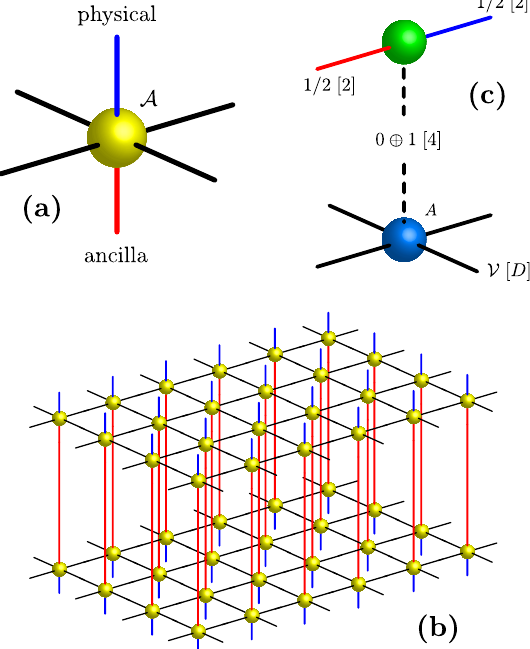
Figure 1: (a) Elementary SU(2)-symmetric C -symmetric on-site tensor A . (b) Ther- 4 v mal density operator written as an (infinite) double layer. A thermal expectation value is obtained by applying local operators on the physical (blue) legs and tracing over all degrees of freedom. (c) Construction of the rank-6 local tensor by contract- ing rank-5 and rank-3 SU(2)-symmetric tensors. The dotted line stands for the 4- dimensional internal space given by the direct sum of the singlet (spin 0) and triplet (spin 1) SU(2)